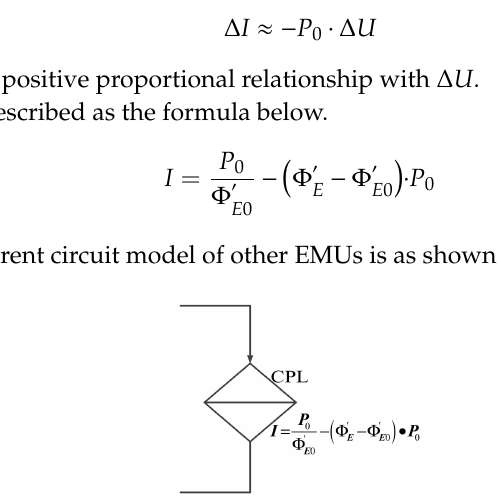
Figure 5. The flux–current circuit model of other EMUs.